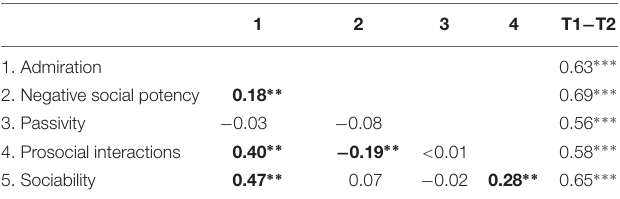
TABLE 2 | Correlations of each subscale at T1 ( n = 271), and Pearson’s correlations between mean subscale scores at T1 and T2 ( n =